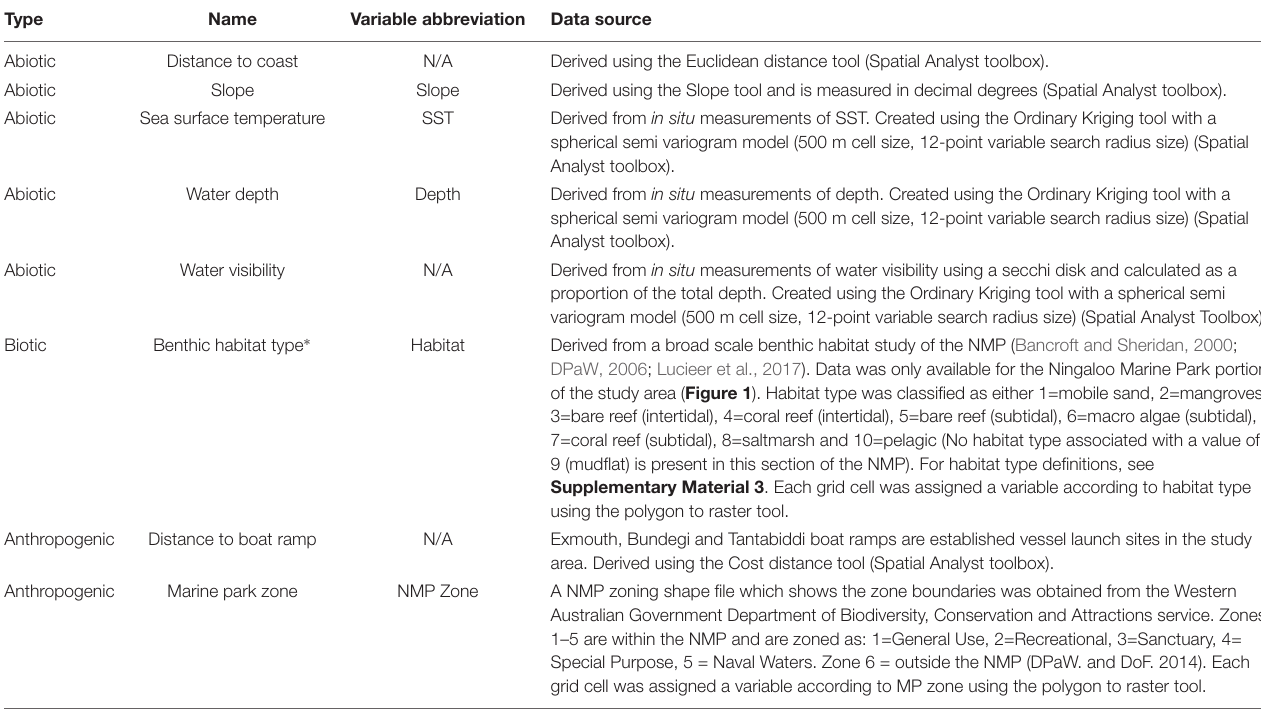
TABLE 1 | List of predictor variables used in species distribution modelling (SDMs) of Indo-Pacific bottlenose dolphins in the coastal waters of the North West Cape, Western Australia, their associated data source and how they were derived in